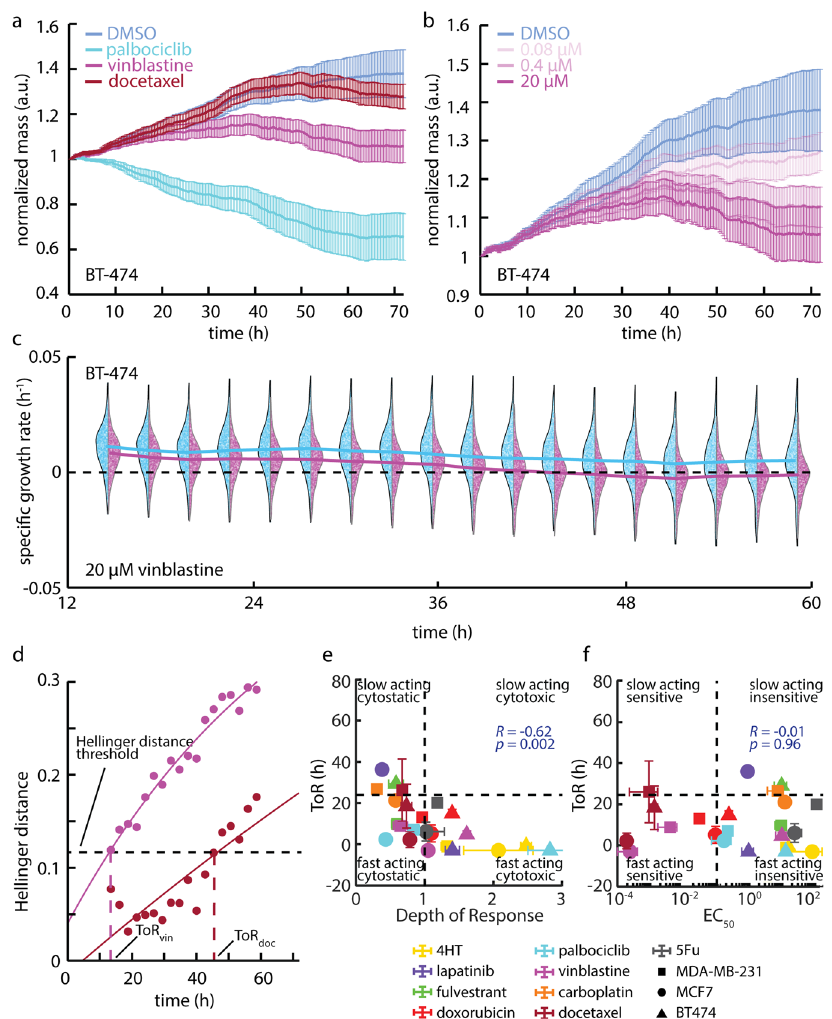
each time point for 20 µ M palbociclib, 20 µ M vinblastine, and 0.016 µ M docetaxel (nearest concentration to the measured EC 50 ). Error bars show